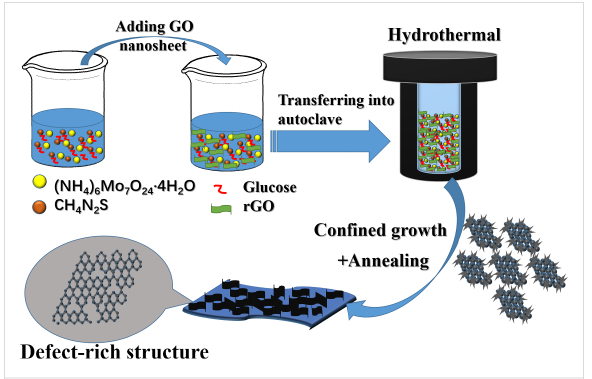
Figure 1: Schematic illustration of the synthesis of C-MoS 2 /rGO com- posite.